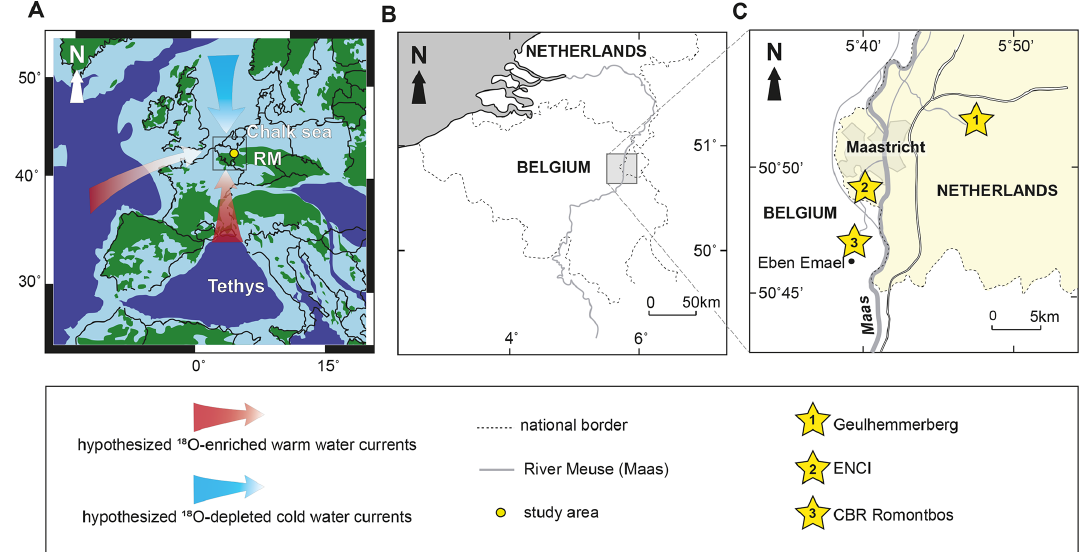
Figure 1. Paleogeography and sample localities used in this study. (a) Late Cretaceous paleogeographic reconstruction of Europe and surrounding regions based on Vellekoop et al. (2022) with the study area (yellow dot) and hypothesized cold- and warm-water currents (blue and red arrows) marked. (b) A map of modern national borders showing the position of the study area. (c) A zoomed-in map of the Maastricht region, showing the location of the ENCI quarry, CBR Romontbos quarry, and Geulhemmerberg subterranean galleries relative to each other and to the city center of